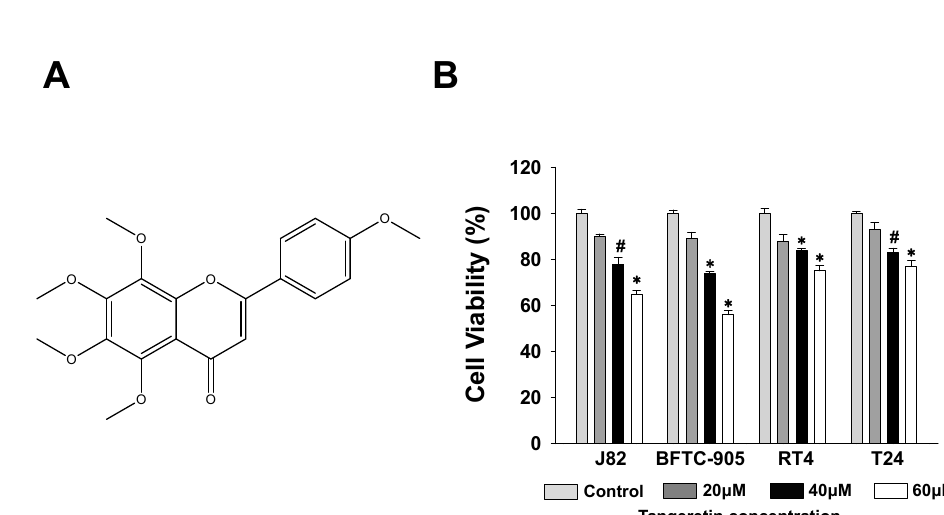
Figure 1. Cell survival of J82, BFTC-905, T24, and RT4 bladder cancer cell lines after tangeretin treatment. ( A ) Chemical structure of tangeretin. ( B ) Cytotoxicity was measured using an MTT assay. # p < 0.05, * p < 0.001.